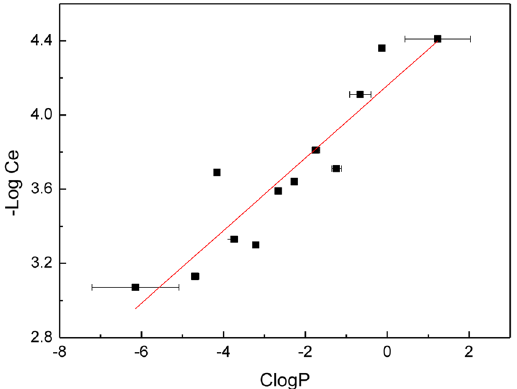
Figure 2. Correlations between concentration and CLogP of 130 metabolites (R 2 = 0.838).